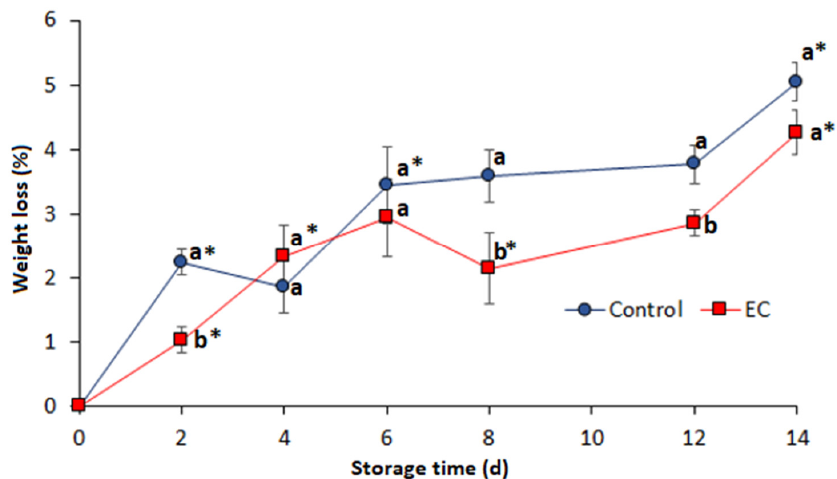
Figure 2. Weight loss (%) of chicken breast fillets with and without the antimicrobial coating stored at 4 °C. Different letters indicate significant differences between treatments for the same sampling day. The asterisk indicates significant differences between consecutive measurement days for the same treatment according to Tukey’s HSD test ( p ≤ 0.05). Standard deviation included ( n = 3).